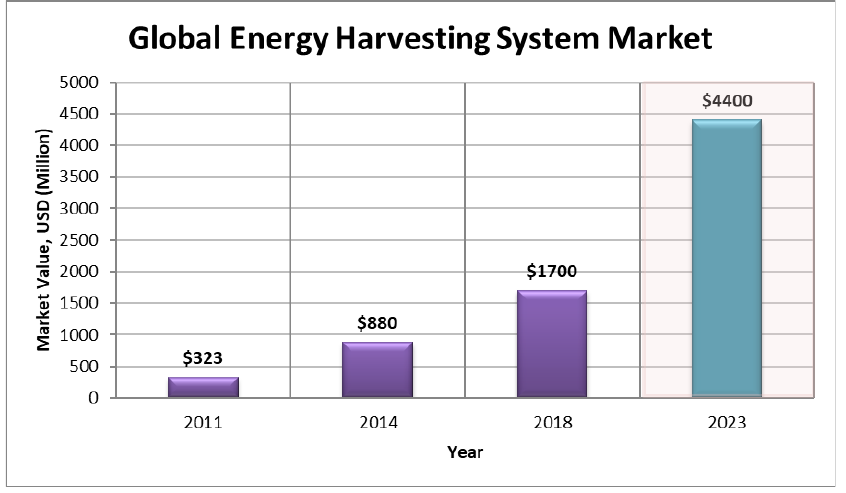
Figure 1. Global energy-harvesting market.